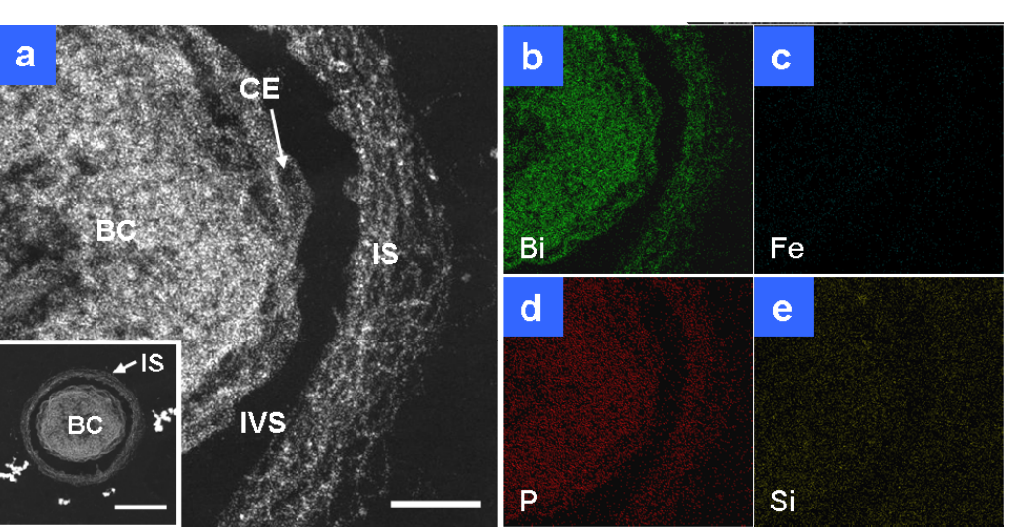
Figure 2. HAADF-STEM images of OUMS1 and associated structures in Bi-stained cross ( a ) Enlarged image of a cross section of a bacterial cell with the immature sheath shown in inset. Note the apparent fibril features of the immature sheath; ( b ) Bi distribution